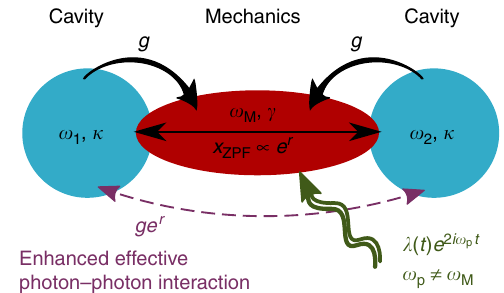
Figure 1 | Sketch of the system. Tunnelling between two optical cavities (blue circles) is mediated by a mechanical mode (red ellipse) on which a large-amplitude, strongly detuned parametric drive is applied to amplify its ^ X quadrature. This scheme results in an exponential enhancement of the single-photon coupling constant g , thereby amplifying the resulting effective photon–photon